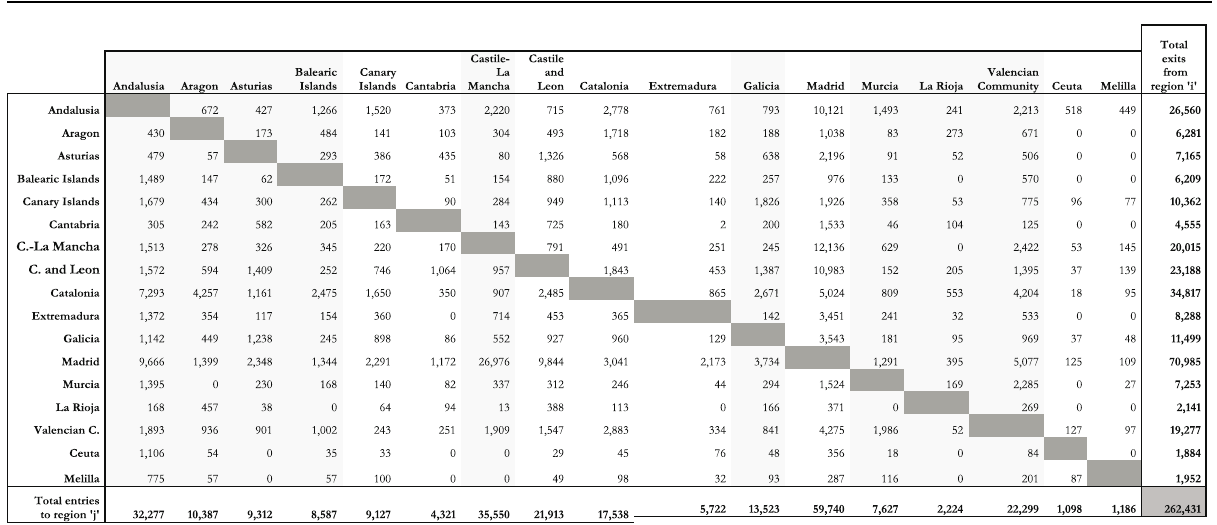
Table 5: Number of changes of residence among non - top - percentile taxpayers between the source region “ i ” ( residence in 2006, column 1 ) and the destination region “ j ” ( residence in 2012, row 1 ) . Population data*